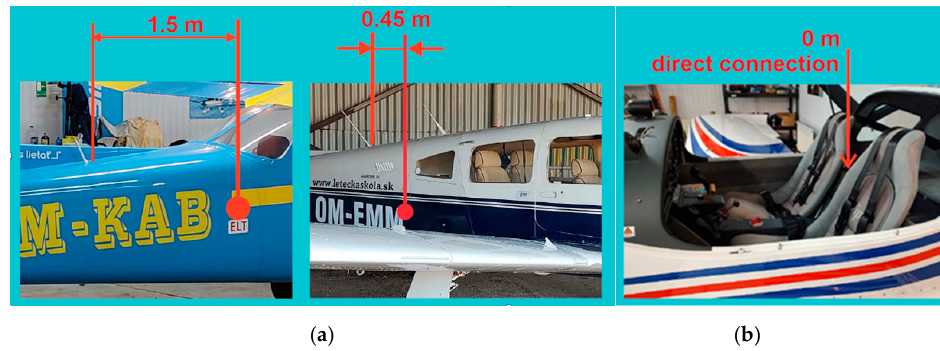
Figure 1. Location of the ELT locating device in the assembly: block–antenna: ( a ) standard location (distance) of antenna and ELT block; ( b ) nontraditional location of antenna and ELT block. A fundamental attribute is the correct positioning of the antenna on the aircraft [7].